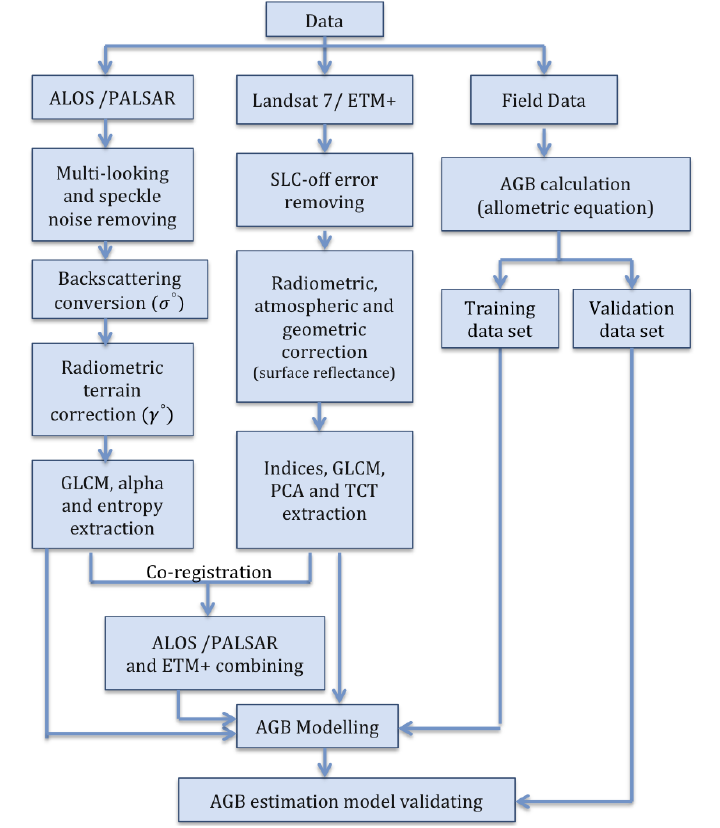
Figure 6. Flowchart of mountain forest AGB estimation